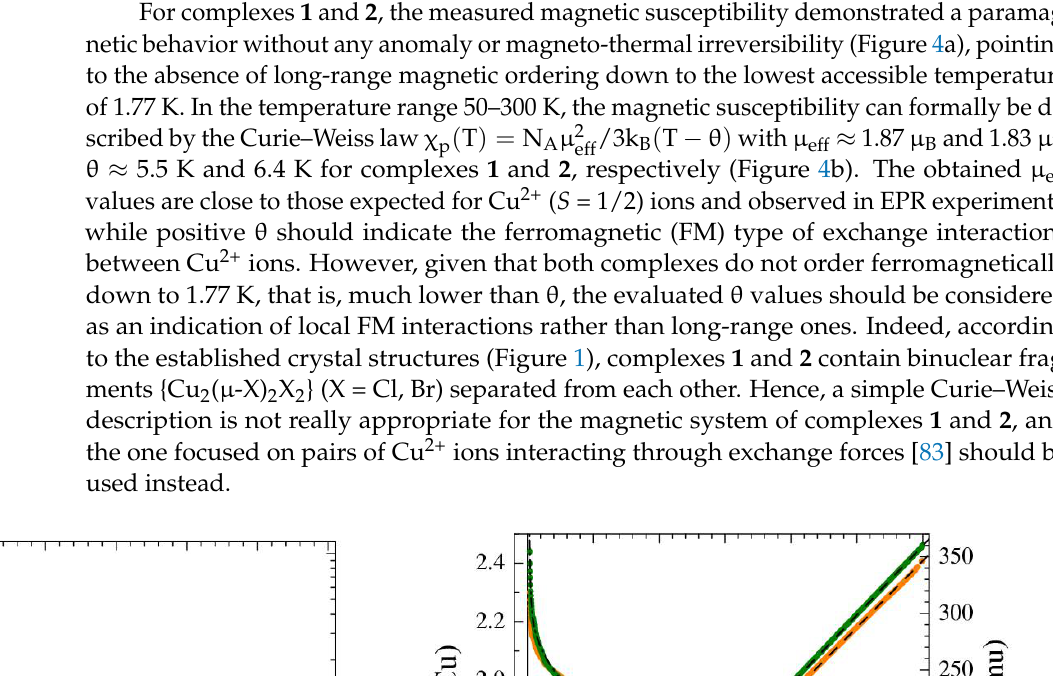
Figure 5. Magnetic field dependence of the magnetization in complexes 1 and 2 at T = 1.77 K. Differences in the magnetic behavior of the two pairs of compounds could be at- tributed to differences in the geometrical parameters of the dimeric {Cu 2 (μ-X) 2 X 2 } (X = Cl, Br) fragment (Table 1). In particular, in the {Cu 2 (μ-Br) 2 Br 2 } dimer of structure 2 , the Cu- Br(bridging) distances differ little from each other (2.4218(7)−2.4572(7) Å) with almost equal Cu-Br(bridging)-Cu angles (92.493(1) and 93.587(1)°), while in structure 4, having the same {Cu 2 (μ-Br) 2 Br 2 } unit, the differences in the Cu-Br(bridging) distances and Cu- Br(bridging)-Cu angles are 0.1141 Å and 5.772°.